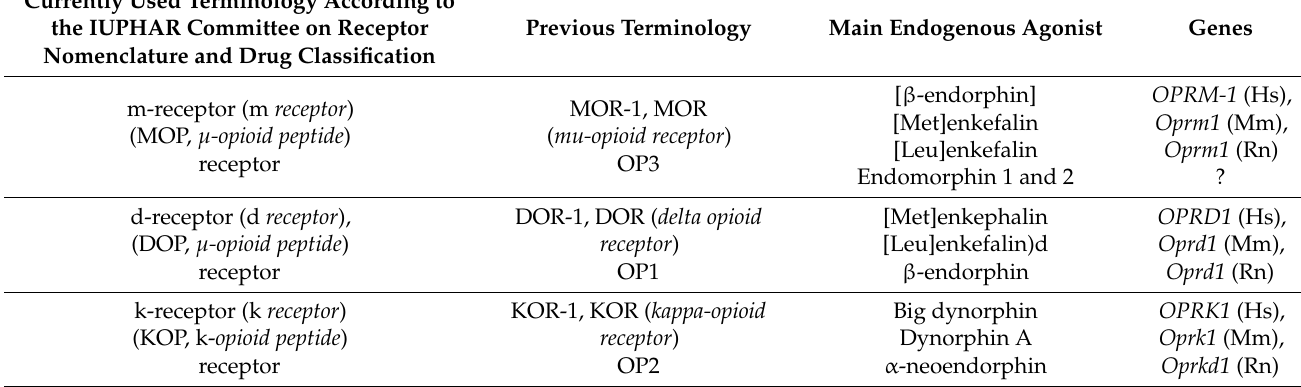
Table 3. Actual and previous terminology of opioid receptors according to The International Union of Basic and Clinical Pharmacology (IUPHAR), their ligands, and the genes encoding them (according to [29]). Currently Used Terminology According to the IUPHAR Committee on